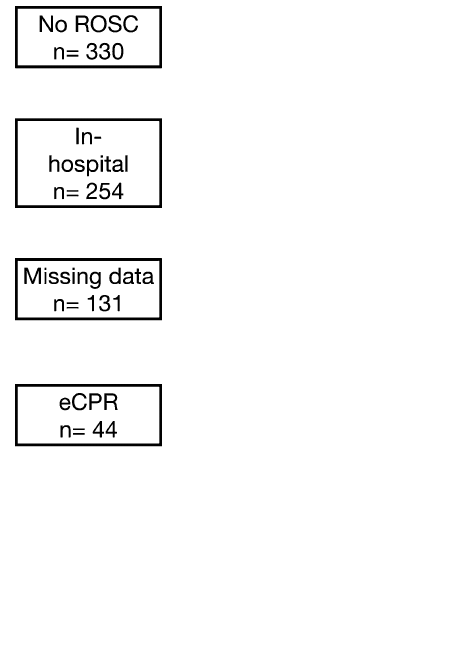
Figure 1. Flowchart of the